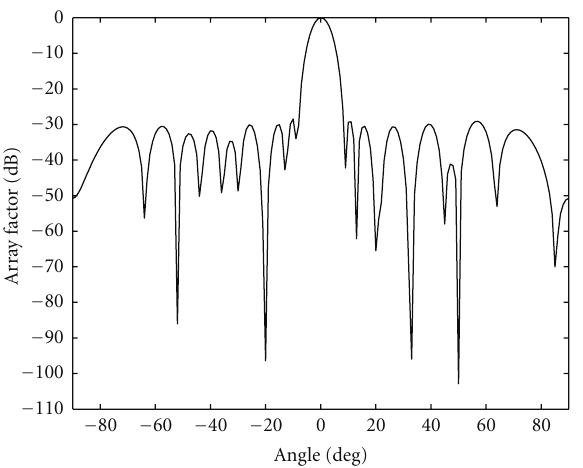
Figure 13: Radiation pattern of 20-element linear broadside array with a broad null at 30 ◦ .